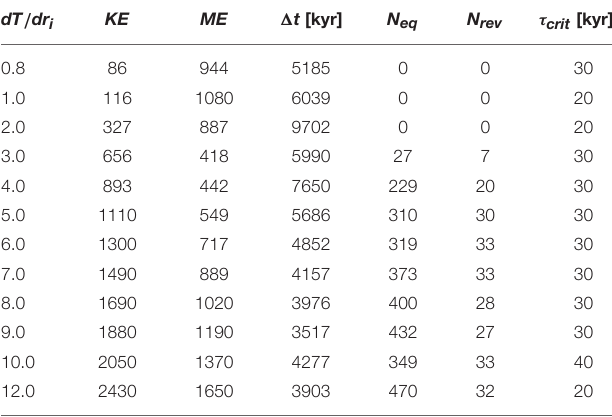
TABLE 1 | Dynamo model properties: basal heat flux dT / dr i , time averaged volumetric kinetic energy (KE) and magnetic energy (ME), length of run 1 t in